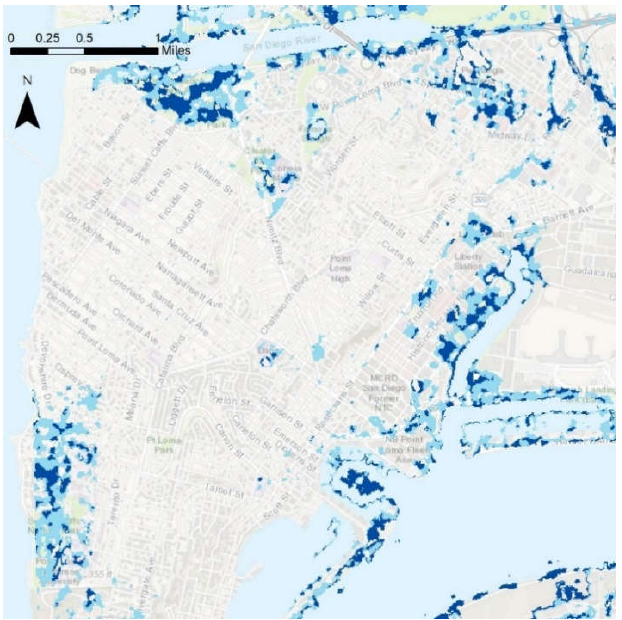
Figure 11. Point Loma Submap.